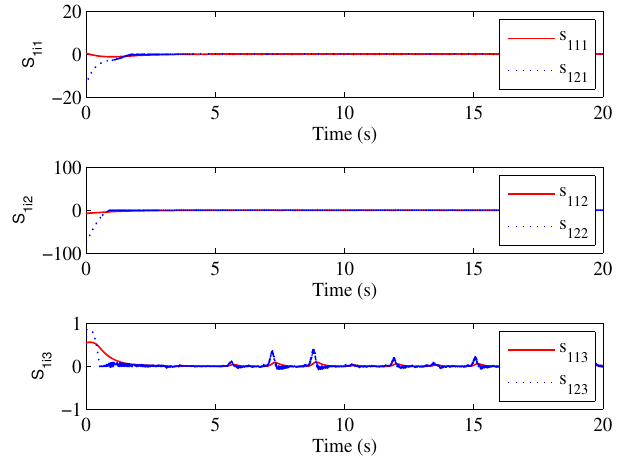
Figure 10. Responses of the PD sliding-mode variable vector s 1 i